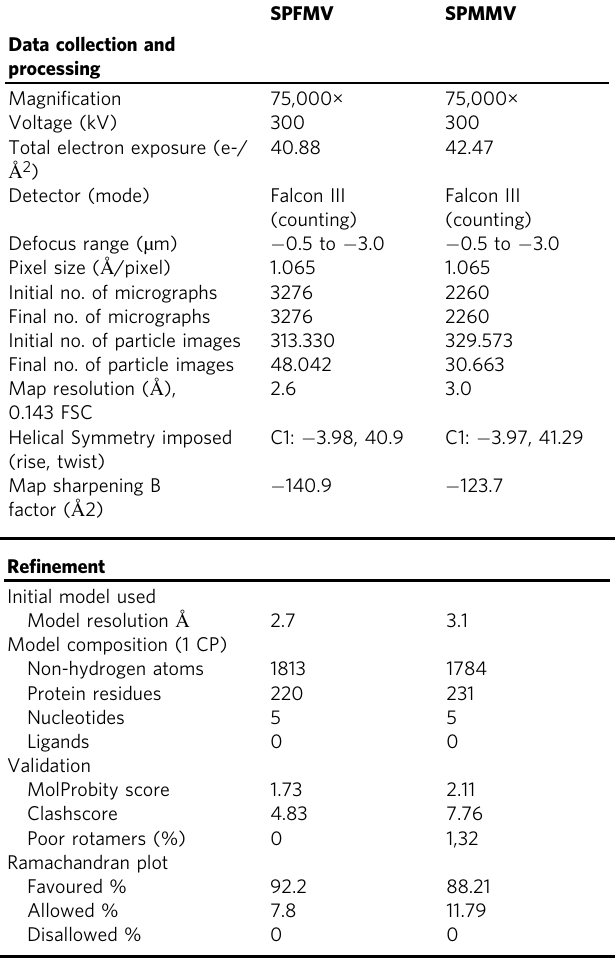
Table 1 CryoEM data analysis